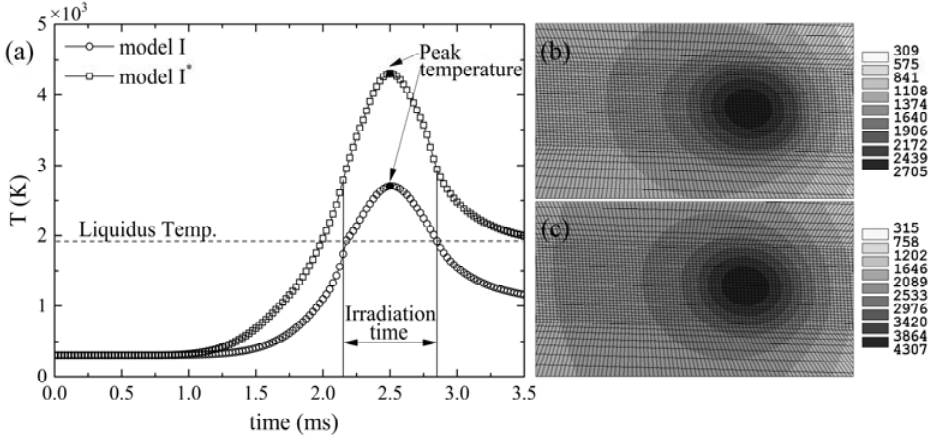
Figure 6. ( a ) Temperature history for a given point which is a distance of 250 μ m away from the start point; ( b , c ) temperature distribution (unit in K) from the model with and without considering the effect of material state and phase changes on laser absorption, respectively. P = 50 W, V = 0.1 m/s, r b = 35 μ m.